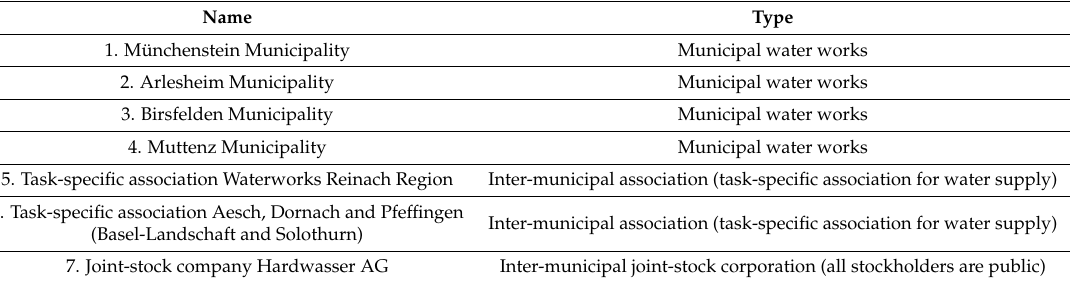
Table 3. Overview of water suppliers and types in Case